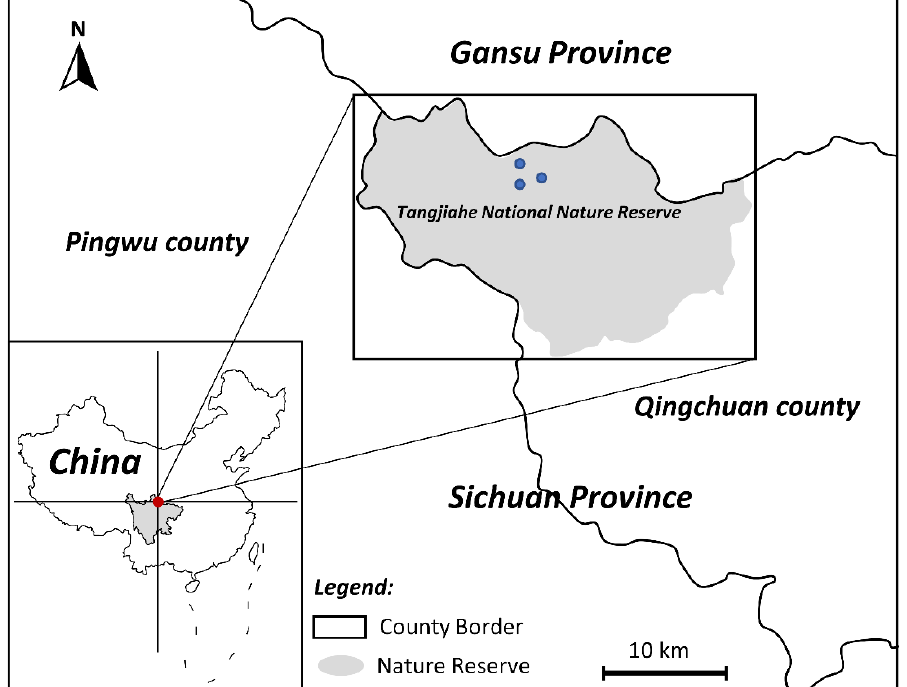
Figure 8. Sampling plots of takin lungworms collected from Tangjiahe National Nature Reserve, China. The red and blue dots on the map are the location of the Tangjiahe National Nature Reserve and the sampling points, respectively.